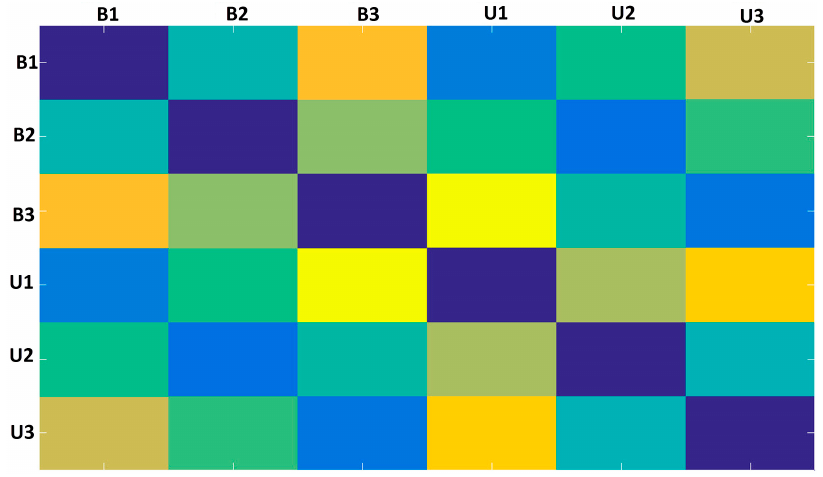
Figure 8. Obtained frame from two random PZT-EMI signatures.